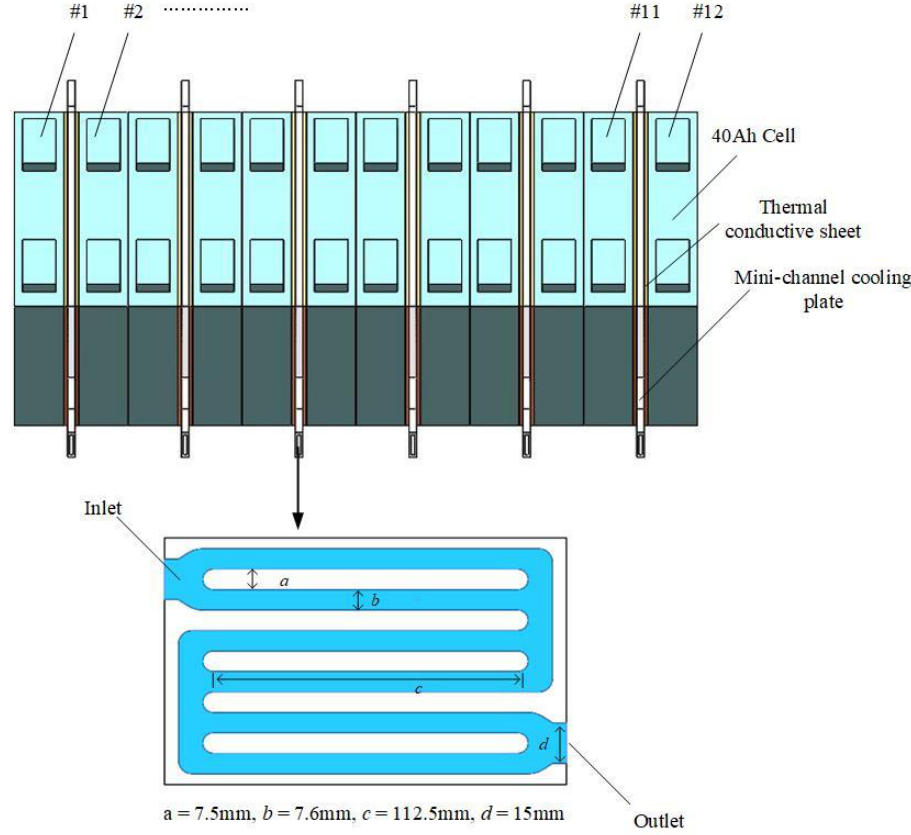
Figure 3. Design of the mini-channel liquid-cooling battery module.